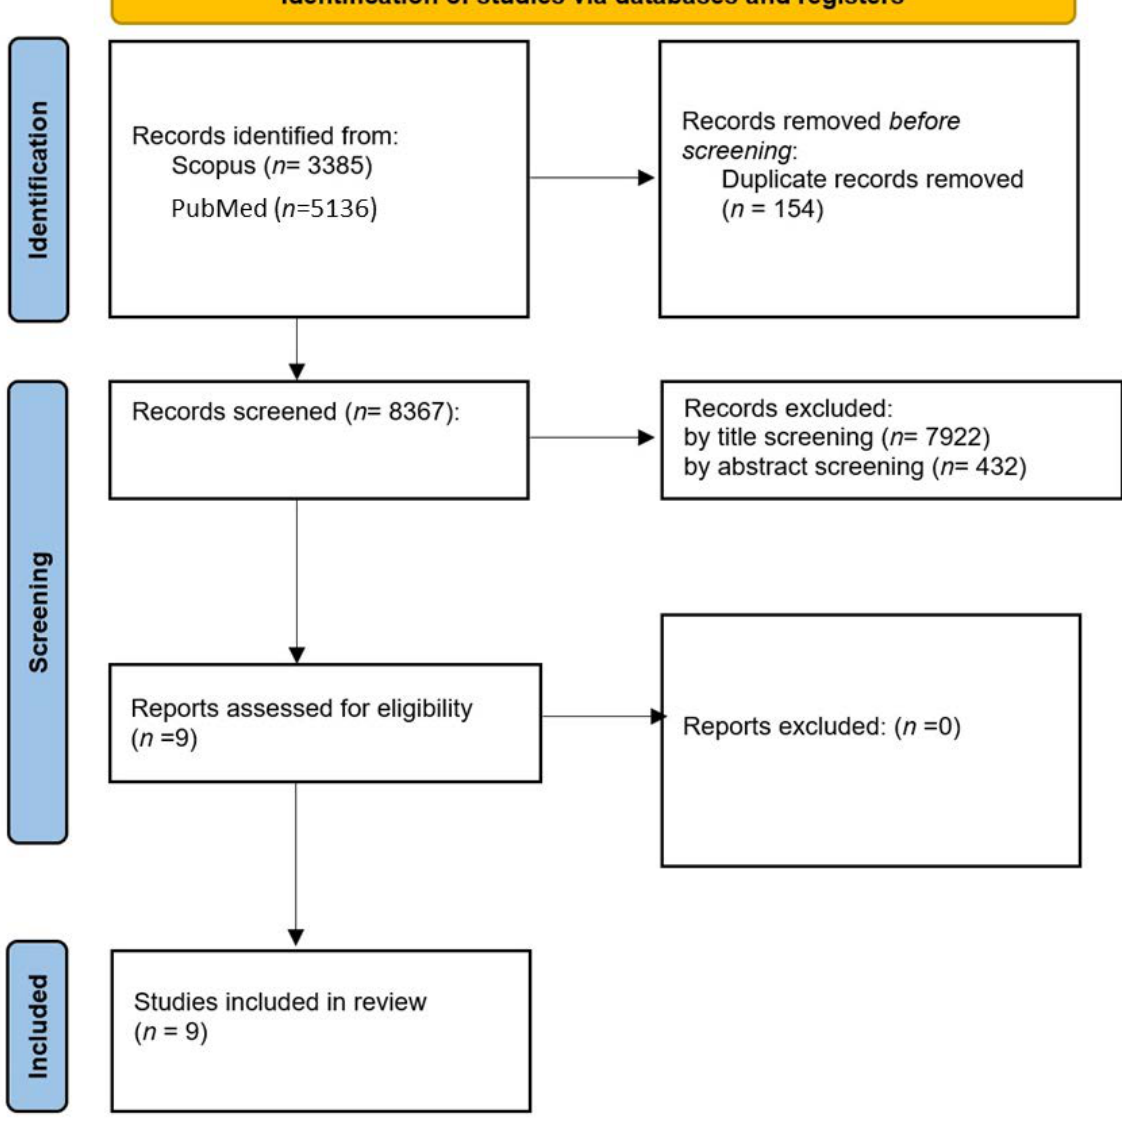
Figure 1. Prisma flowchart of the study